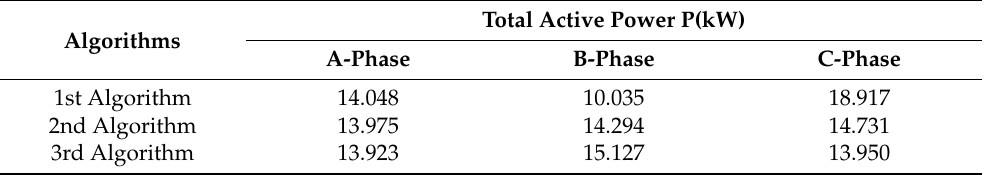
Table 3. Active power at each phase for the low voltage distribution system.